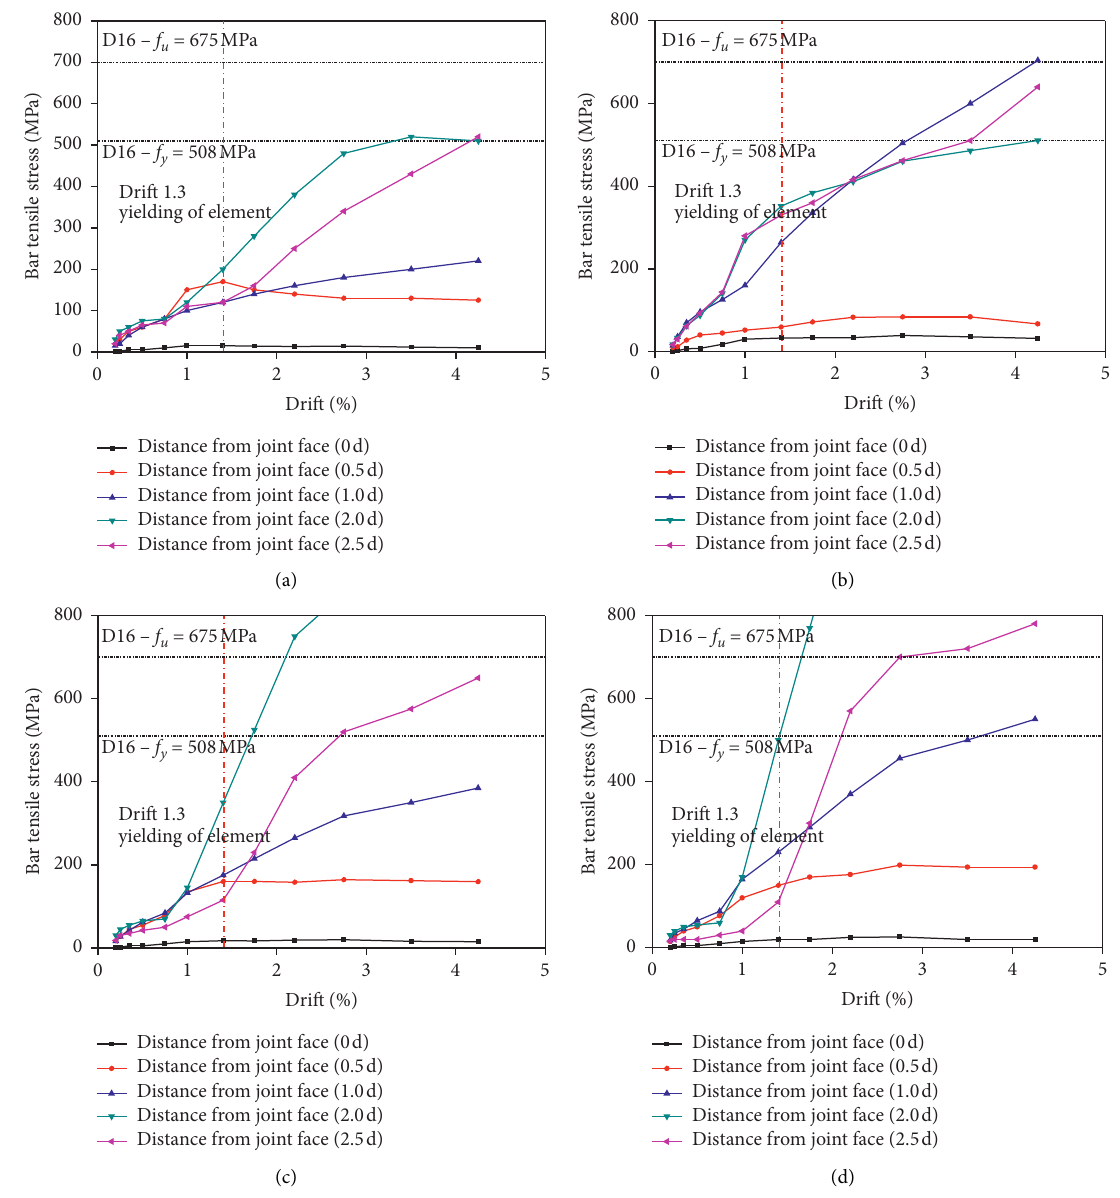
Figure 17: Stress distribution according to moment strength ratio (specimen PC-I50-0.2). (a) Moment strength ratio of 1.0. (b) Moment strength ratio of 1.2. (c) Moment strength ratio of 1.4. (d) Moment strength ratio of 1.6.